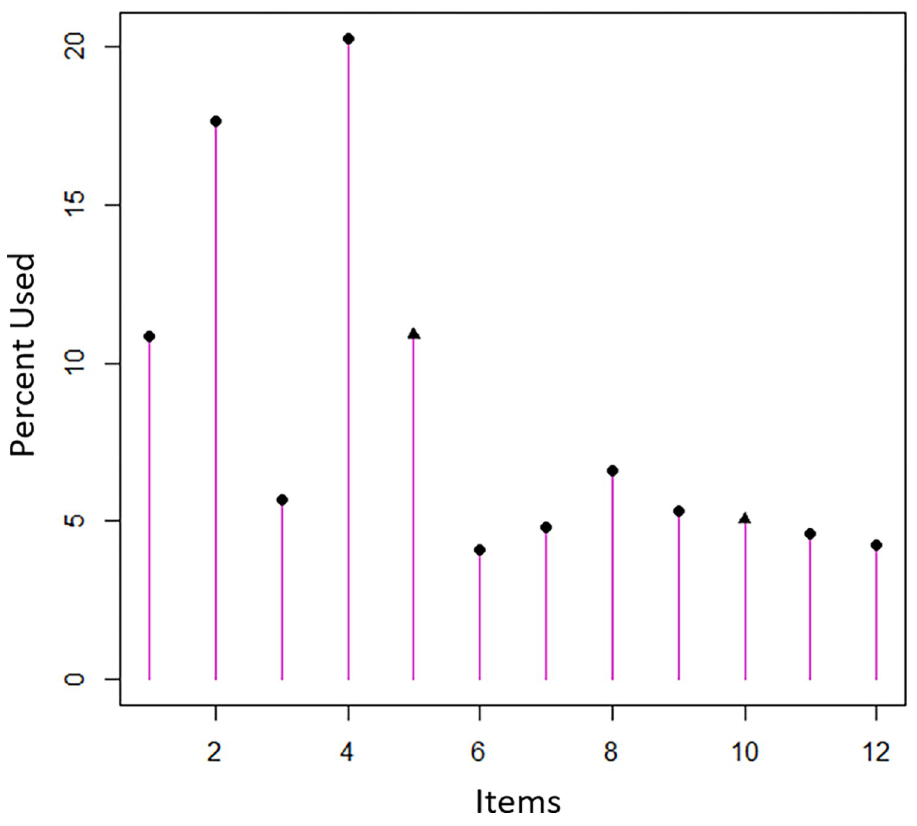
Fig 5. Frequency of items used in the ENRICh CAT simulation.